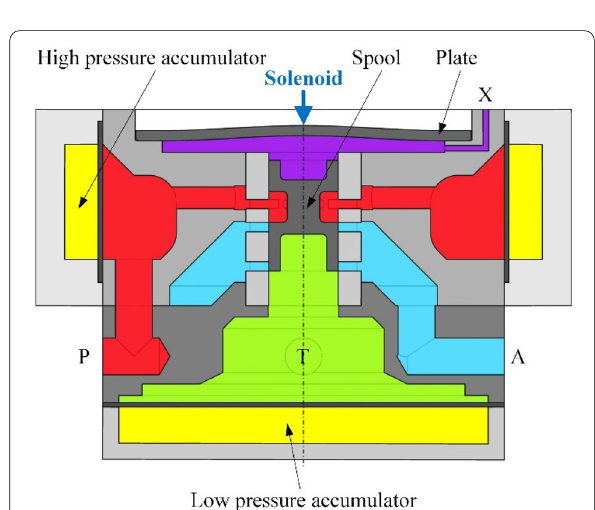
Figure 2 Spool valve with a plate-style armature designed by